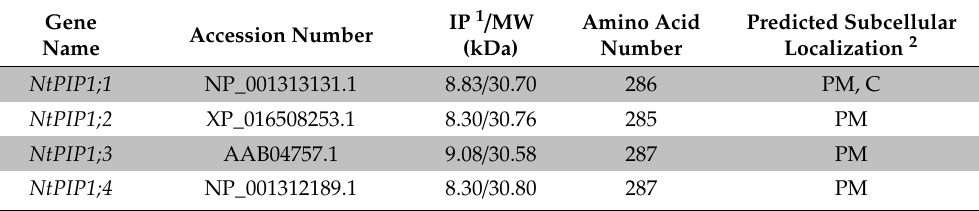
Table 1. Aquaporin genes in the N. tabacum